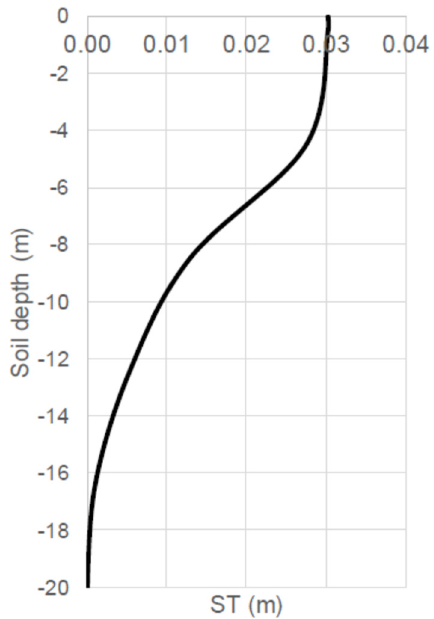
Figure 9. Settlement Vs soil depth (input motion: RRS).